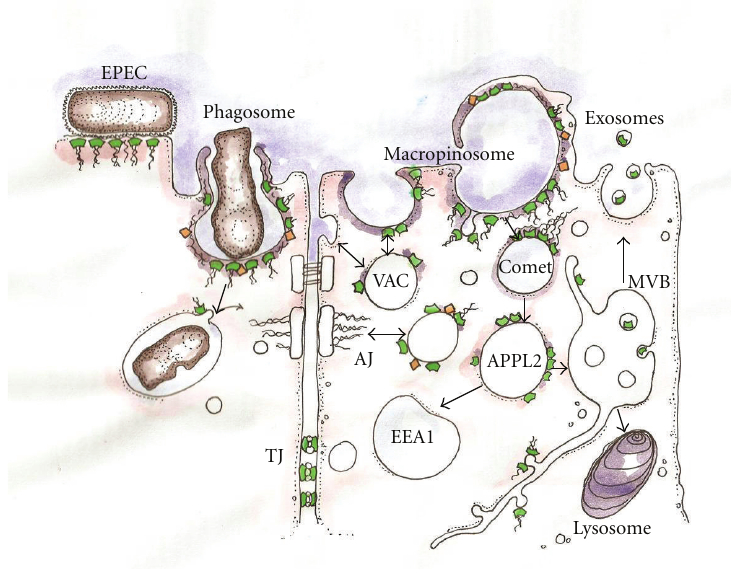
Figure 2: Recruitment of AnxA2 to several sites in the endocytic pathway. AnxA2 is shown as little green structures, filamentous actin as wavy lines, and Src is represented as orange diamonds. EPEC: Association with the actin-rich pedestals of noninvasive enteropathogenic E.coli . Phagosome: AnxA2 is recruited to actin-rich phagosomes during pigmented retinal epithelial cell phagocytosis of rod outer segments. Macropinosome: AnxA2 is recruited to PI(4,5)P2-rich (purple shading) macropinosomes and is absolutely required for their actin-based rocketing (Comet). Macropinosomes or other early endosomes may mature into APPL2/OCRL1-positive early endosomes. These in turn mature into EEA1-positive endosomes. Endocytic tra ffi cking appears to be involved in formation and reformation of the adherens junction (AJ) and extracellular AnxA2/S110A10 complex, which may be released in exosomes when multivesicular late endosomes (MVBs) fuse with the plasma membrane that may contribute to tight junction stability by cross-linking adjacent membranes. The role of AnxA2 in formation of the apical domain is more speculative but may involve formation of a preformed vacuolar apical compartment (VAC), which then may fuse with the apical